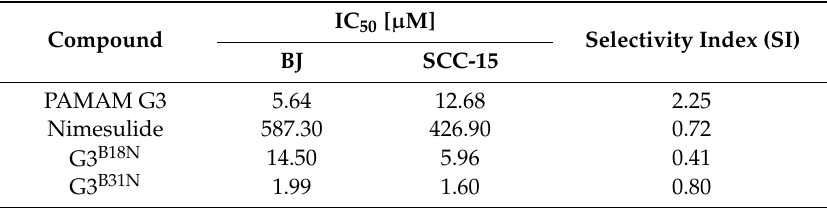
Table 1. IC 50 values and Selectivity Index (SI) obtained with NR assay after 24 h treatment with dendrimer conjugates, native PAMAM G3, or nimesulide